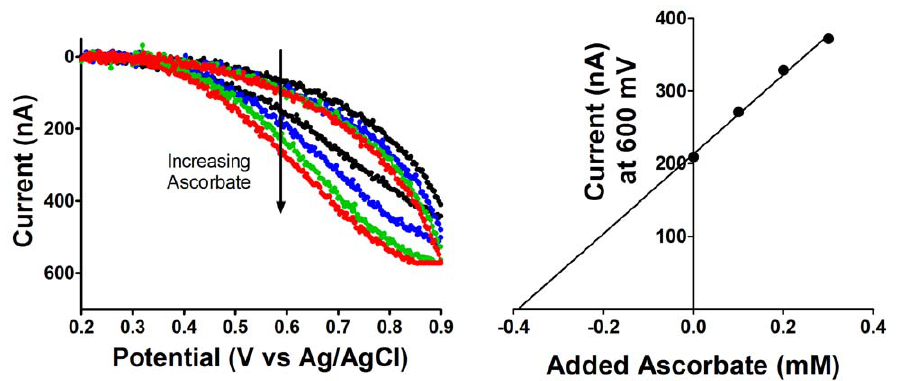
Figure 2. The CheapStat supports cyclic voltammetry. Shown is the CV-based measurement of ascorbic acid (Vitamin C) in orange juice, using the method of standard additions. (Left) To do so, 0, 5, 10, and 15 mL of an ascorbic acid standard solution (at 0, 0.1, 0.2, and 0.3 M in orange juice) were added to a 25 mL sample of name-brand orange juice and interrogated via cyclic voltammetry performed using an inexpensive pencil ‘‘lead’’ as the working electrode. (Right) A linear extrapolation of the oxidation current observed at 600 mV was used to determine the initial ascorbate